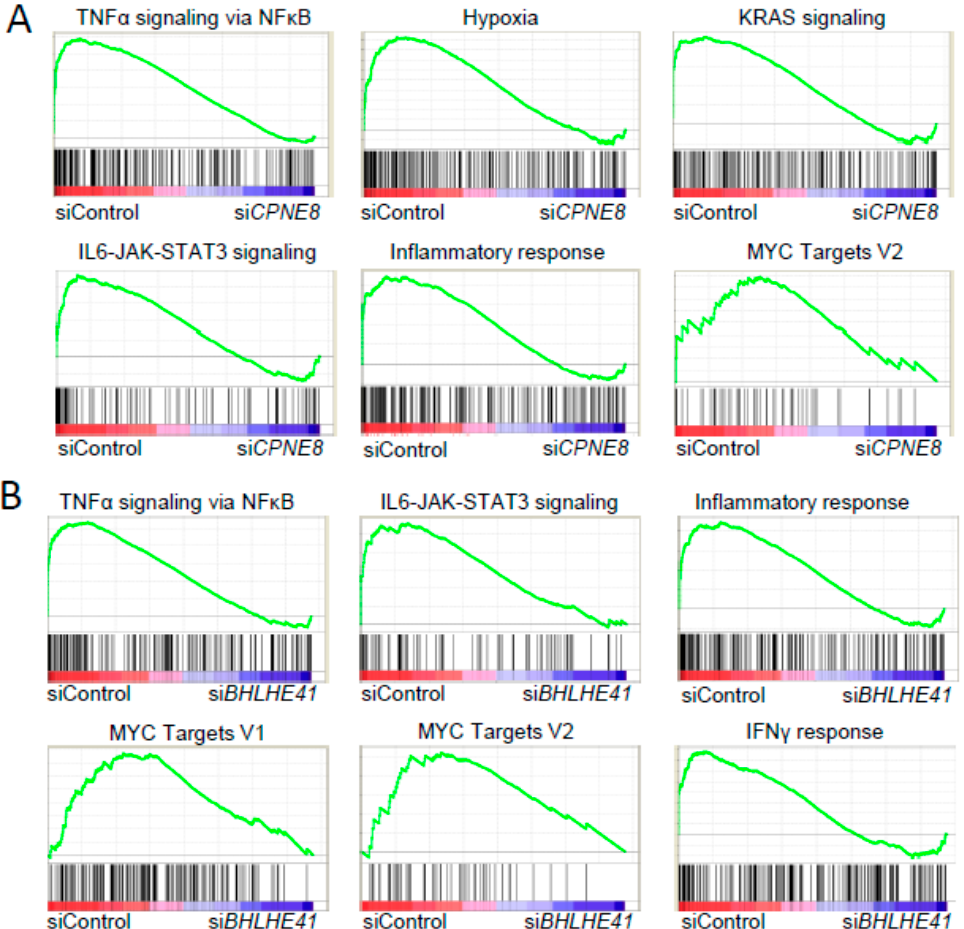
Figure 5. Enriched pathways observed with siRNAs targeting CPNE8 and BHLHE41 . ( A ) Gene Set Enrichment Analysis (GSEA) enrichment plot of microarray analysis of RMG1 cells in siControl versus CPNE8 -specific siRNAs. ( B ) GSEA enrichment plot of microarray analysis of OVCAR3 cells in siControl versus BHLHE41 -specific siRNAs. The X and Y axes represent “rank in ordered dataset” and “enrichment score”, respectively.